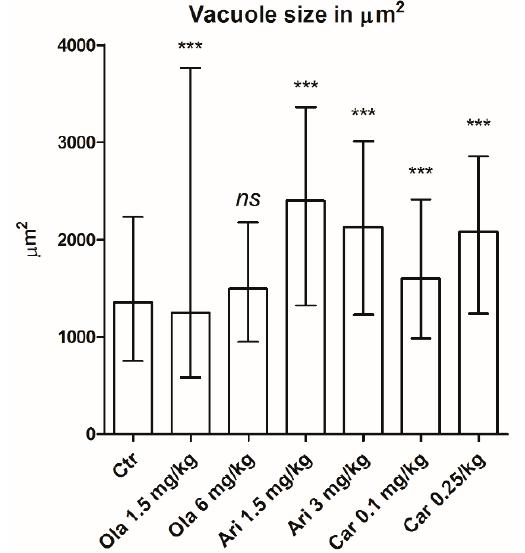
Figure 3. Adipocyte vacuole size expressed in µm 2 (data presented as median with interquartile range) of different groups. Statistically significant differences compared to the Ctr (Kruskal–Wallis test and Dunn’s multiple post-hoc comparison) are noted with *** ( p < 0.001). Great dispersion of vacuole sizes can be observed, because large lipid-laden vacuoles, as well as preadiocytes were present in great number, thus resulted considerable deviation of data.